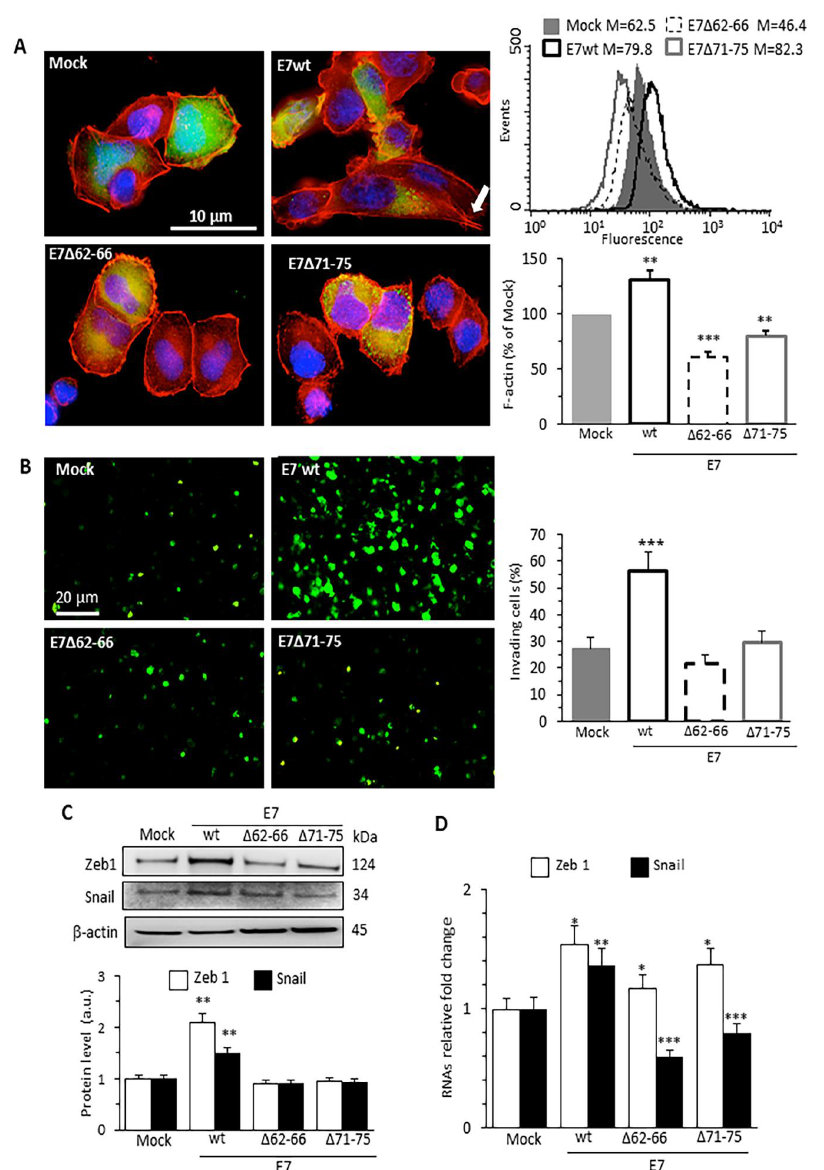
Figure 1. HPV16E7 expression promotes actin cytoskeleton remodeling, cell invasion ability and EMT in human cervical cancer cells. ( A ) IVM analysis after double-cell staining with TRITC-phalloidin (red) and Hoechst (blue) in C33A cells transfected (green) with pAmCyan empty vector (Mock), pAmCyan-HPV16E7 wild-type (E7wt) or deletion (E7mut) mutant constructs pAmCyan-HPV16E7 ∆ 62–66 (E7 ∆ 62–66) or pAmCyan-HPV17E7 ∆ 71–75 (E7 ∆ 71–75). E7wt-expressing cells show different morphological features compared to both Mock- and E7 mutant transfected cells. Arrow indicates protrusive and invasive structures (left). Flow cytometry evaluation of the intracellular amount of F-actin restricted to pAmCyan-positive cells. Histograms obtained in a representative experiment are shown. Bar graph shows the mean ± SD of the median fluorescence intensity obtained in four different experiments. ** p < 0.01 and *** p < 0.001 vs. Mock transfected cells (right). ( B ) Representative images of transwell invasion assay of pAmCyan C33A transfected cells (left). Fluorescence emission of C33A migrating through Matrigel are quantified by IVM analysis and expressed as percentage (right). ( C ) Western blot analysis of the expression of the EMT markers Zeb1 and Snail. β − actin determination was used as loading controls. Bar graph (bottom) shows relative densitometry quantitation of each protein normalized to β -actin obtained in three independent experiments and reported as mean ± SD. ** p < 0.01 vs. Mock transfected cells. Uncropped western blot figure available in Supplementary Figure S5. ( D ) Bar graph showing the evaluation of mRNA levels of Zeb1 and Snail performed by qRT-PCR assay. Data are reported as mean ± SD of RNAs relative fold change vs Mock-transfected cells obtained in three independent experiments. * p < 0.05, ** p < 0.01 and *** p < 0.001 vs. Mock transfected